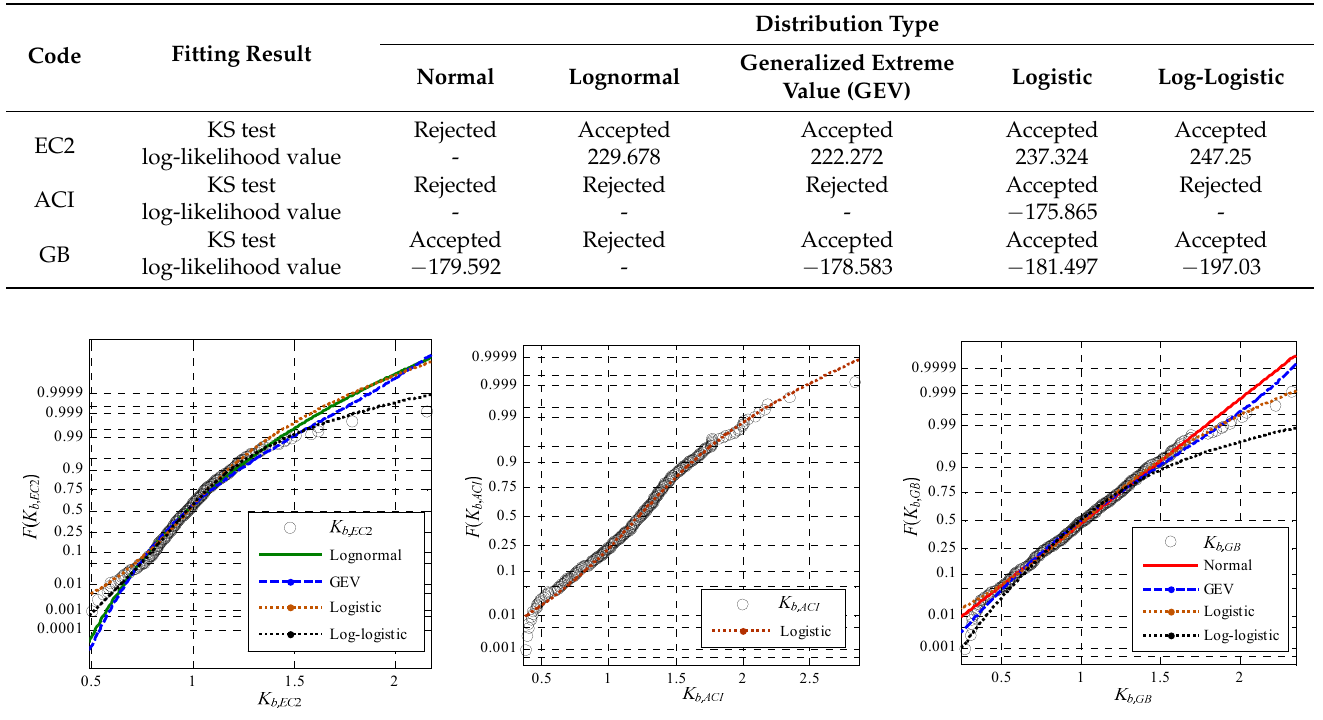
Table 2. Fitting results of the model uncertainty K pb .